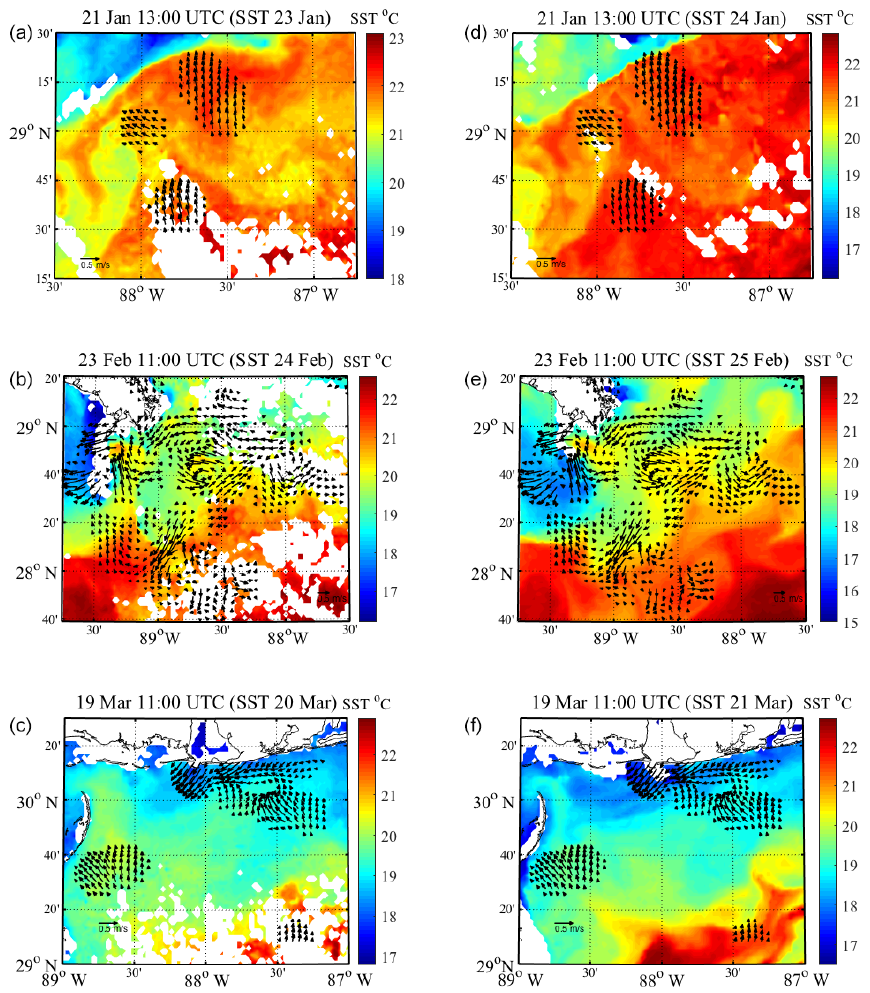
Figure 8. Eulerian velocity fields of the regional circulation that preceded each high wind event, created using LAVA for undrogued drifters in the area, plotted on top of the same 24h averages of SST data shown in Fig. 7. Titles and data are plotted in the same manner as in Fig.